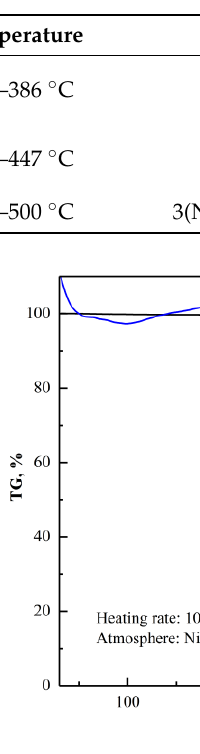
Figure 12. The thermogravimetry–differential scanning calorimetry (TG-DSC) curve of (NH 4 ) 2 SO 4 .